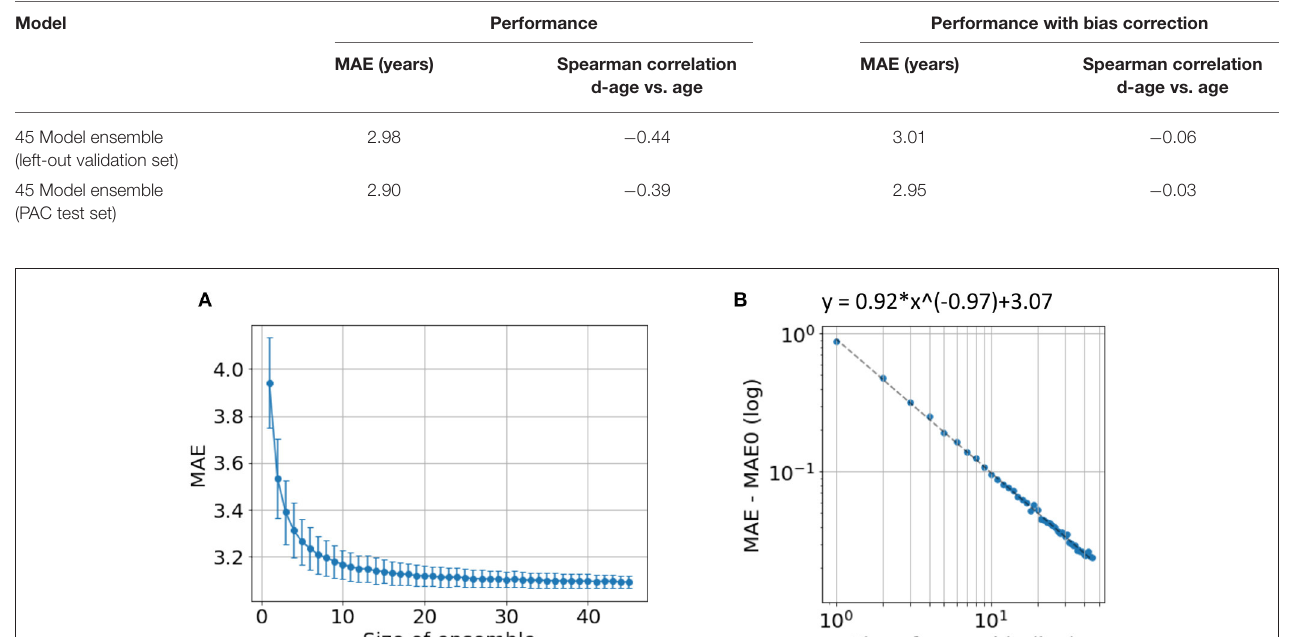
TABLE 3 | Bias correction results.